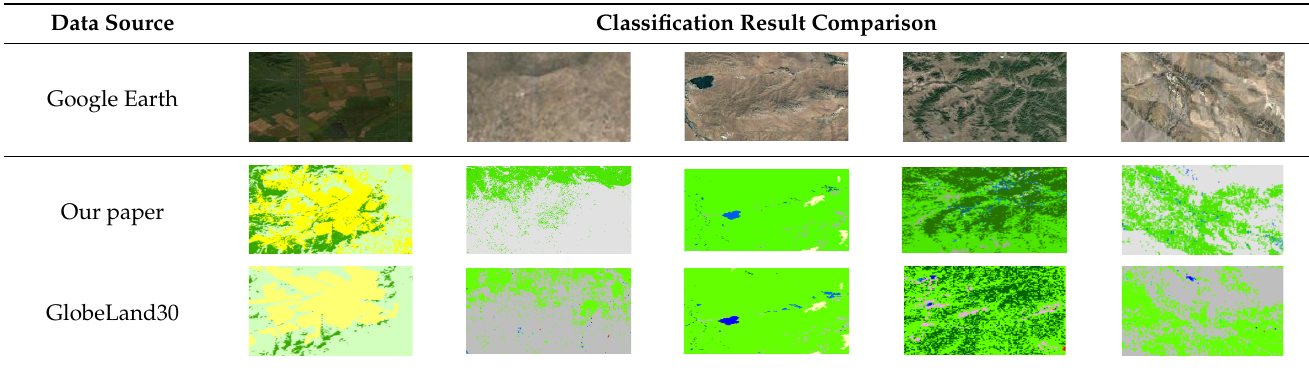
Table 5. Verification of classification results.